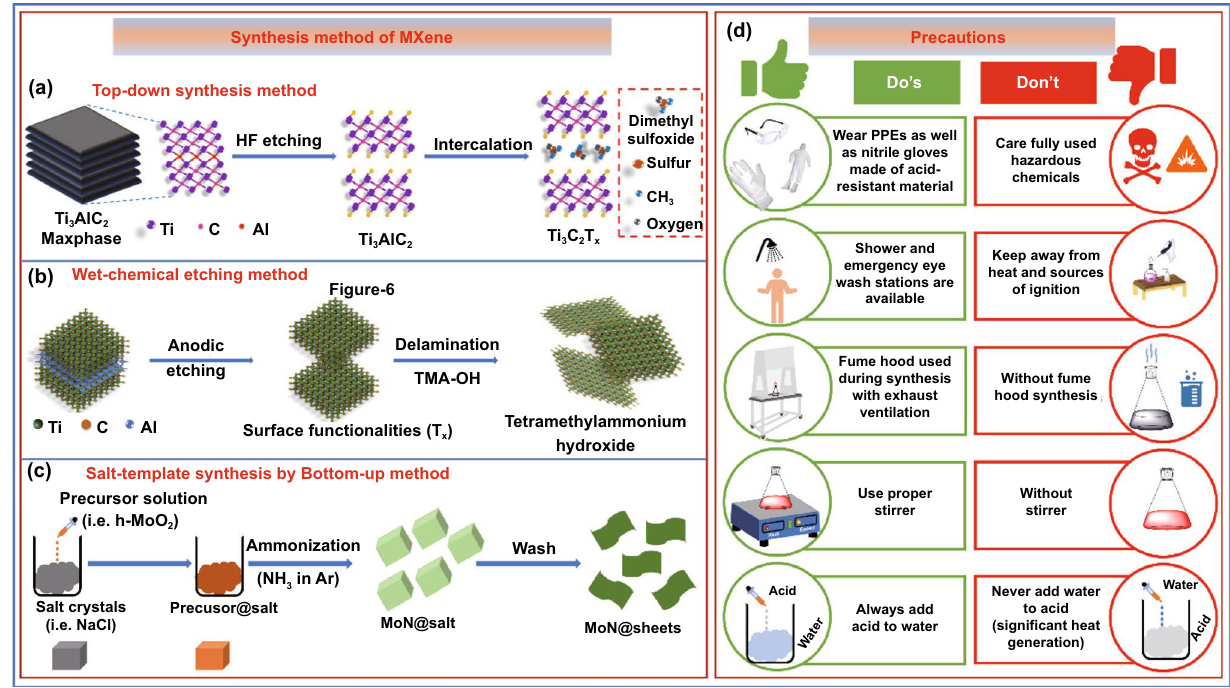
Fig. 6 Synthesis method of MXene. a Top-down synthesis method, b wet chemical etching method, c salt-template synthesis by the bottom-up method, d safety measures and general instructions for